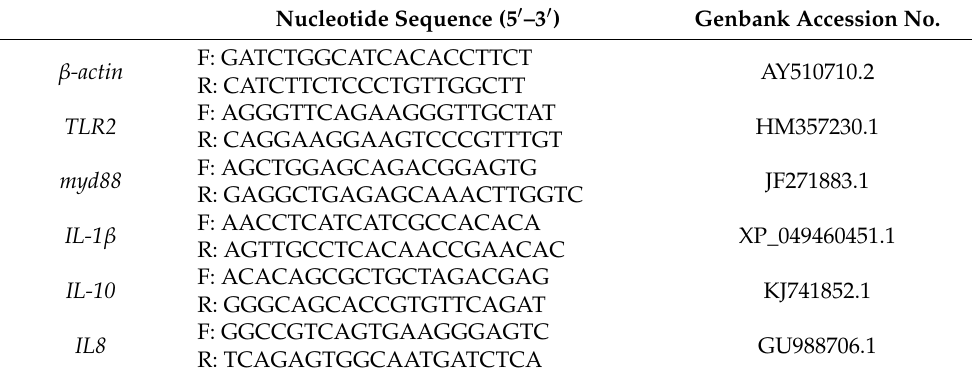
Table 2. Primers pair sequences for real-time